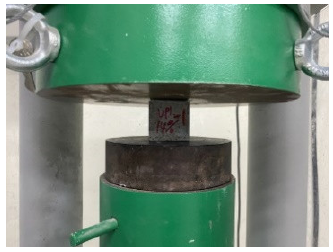
Figure 7. Cubic mold compressive strength test. Table 3. Results of compressive strength test with cubic mold.